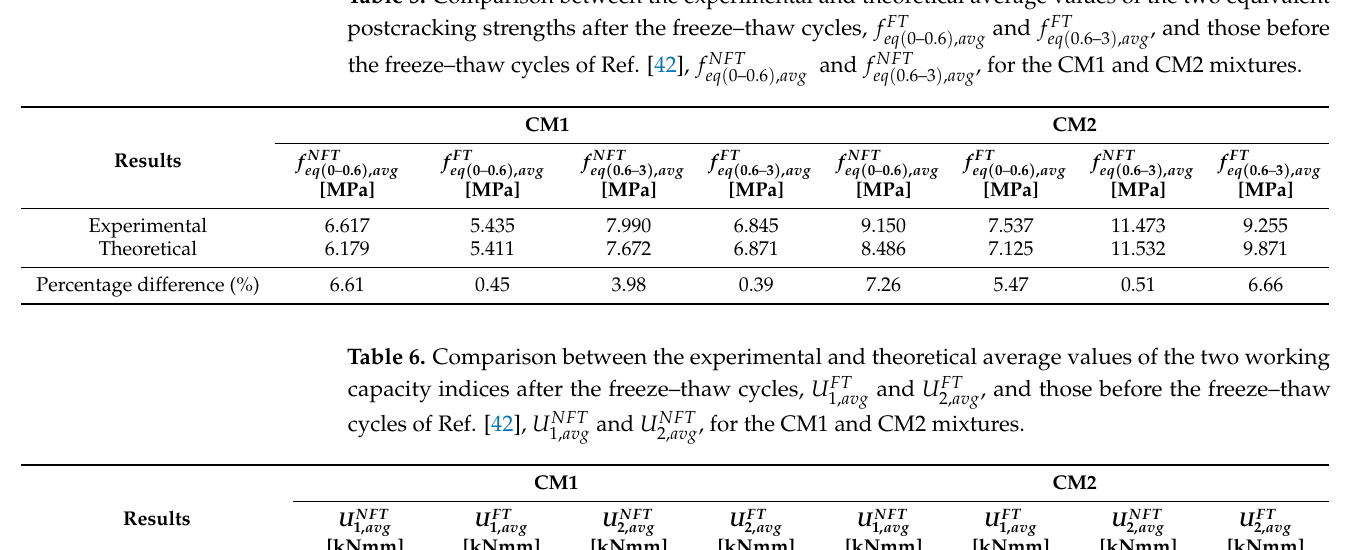
U FT and U FT , are summarised in Table 6, for the CM1 and CM2 mixtures, in which the 2, avg 1, avg